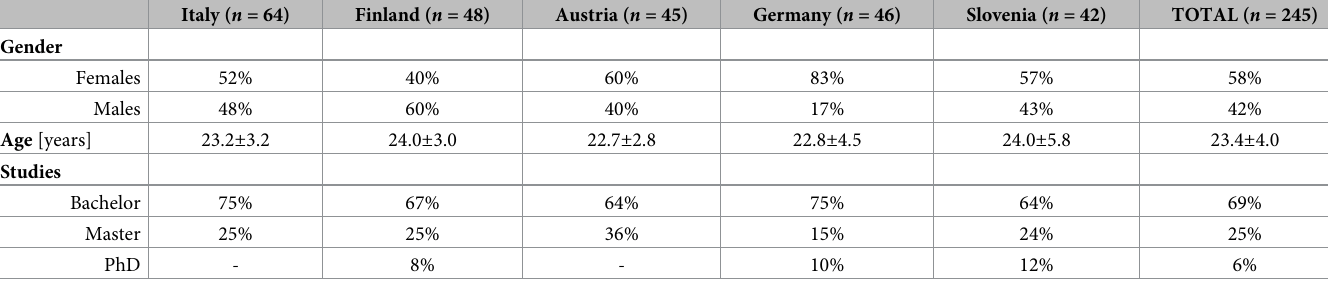
Table 1. Demographic characteristics of the